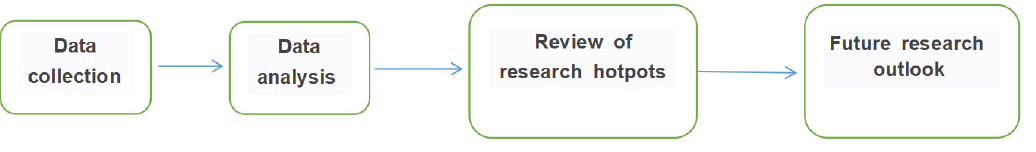
Figure 1. Research Framework.